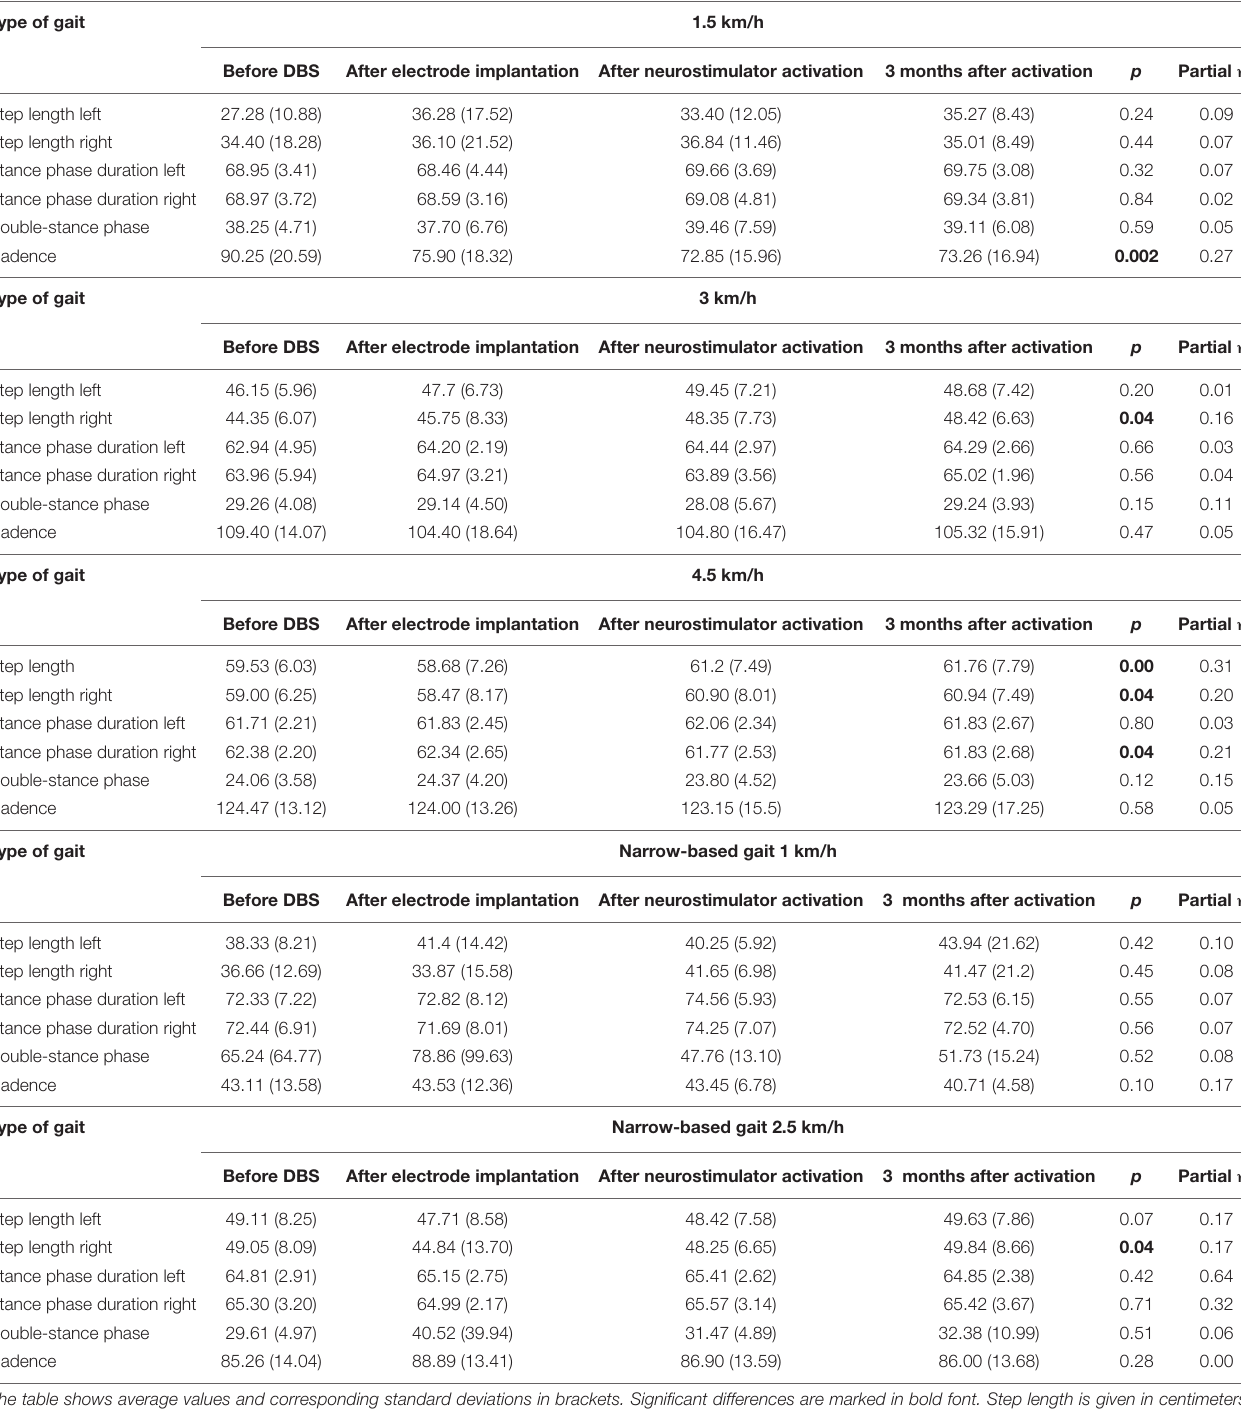
TABLE 3 | Biomechanical parameters of gait.